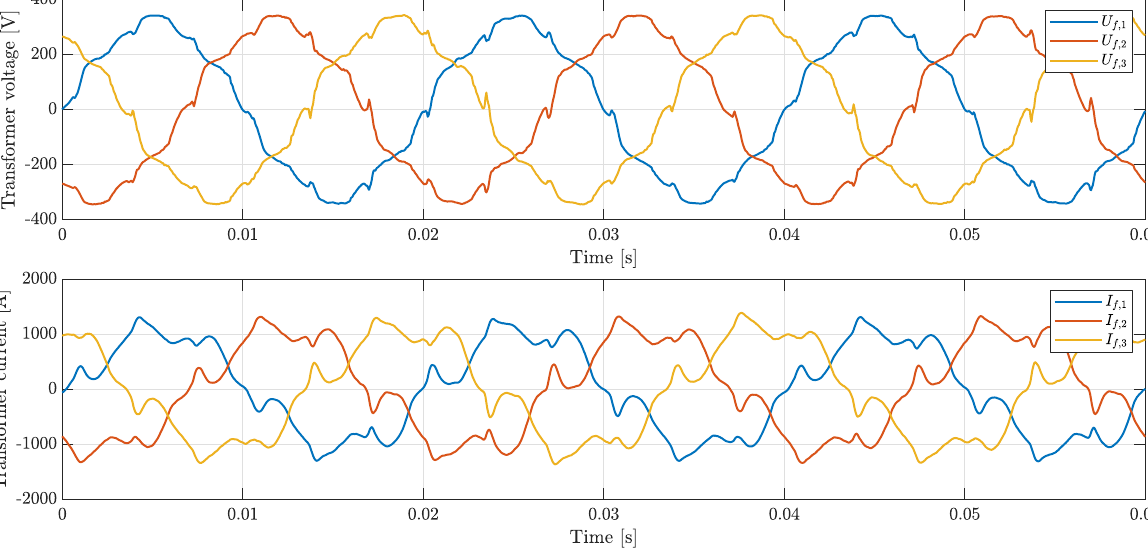
Figure 14. C2—Secondary voltage and current of transformer T1 after switching on the capacitor